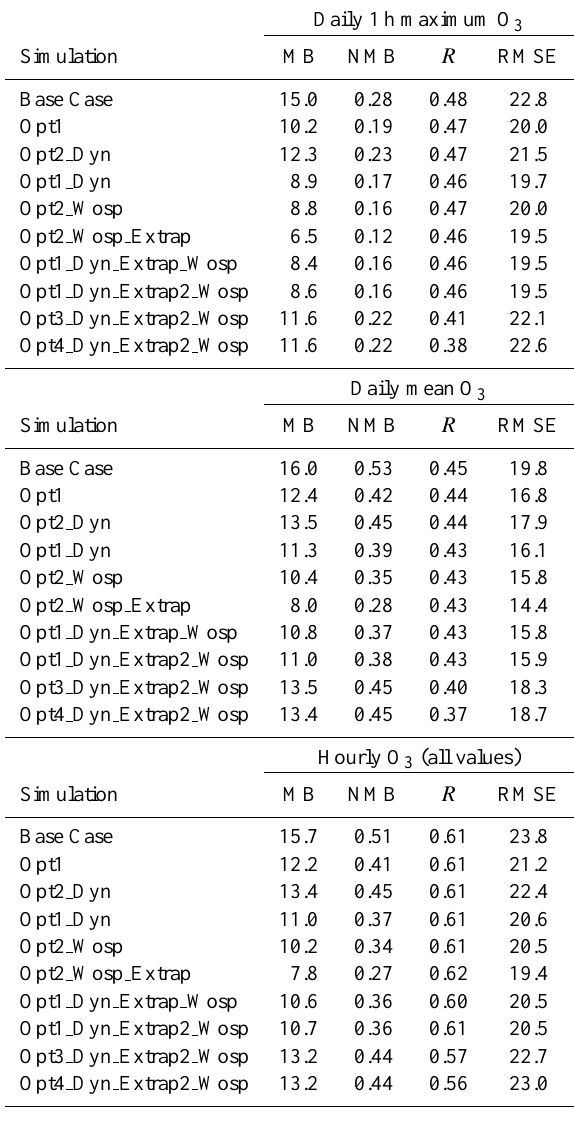
Table 2. Evaluation statistics for 42km grid simulations for Ozone. MB: mean bias, NMB: normalized mean bias, R : correlation coef- ficient, RMSE: Root Mean Square Error. 1167